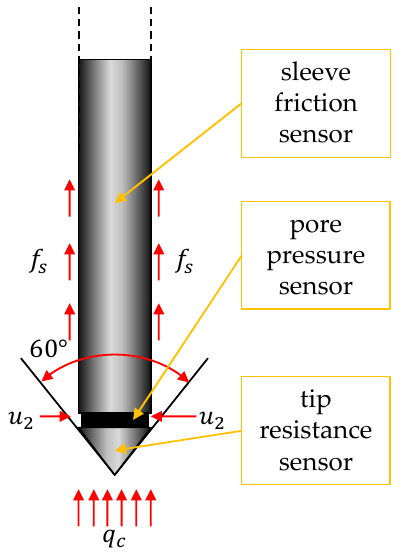
Figure 1. Schematic view of CPTu piezocone